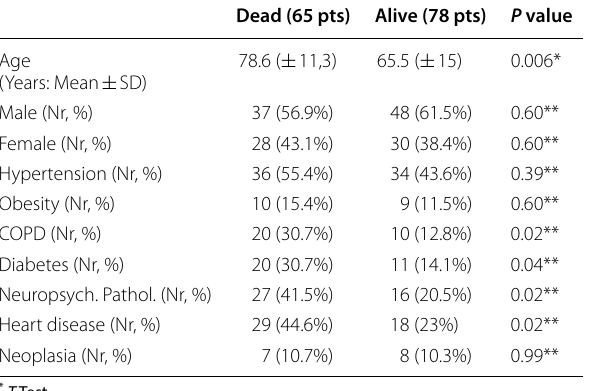
Table 1 Demographic characteristics and coexisting conditions among COVID-19 disease non-survivors and survivors